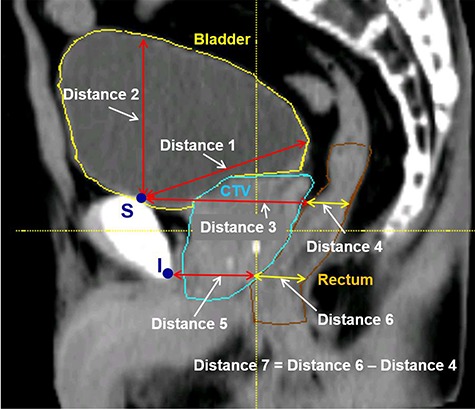
Definitions of distances 1–7 to determine the rectum and bladder anatomical features (features 1–7) selected from a planning CT image. The superior–posterior edge of the pubic bone was defined as feature point S, and the inferior–posterior edge of the pubic bone was defined as feature point I. The features express the variations of the bladder and rectum based on the pelvic bone.